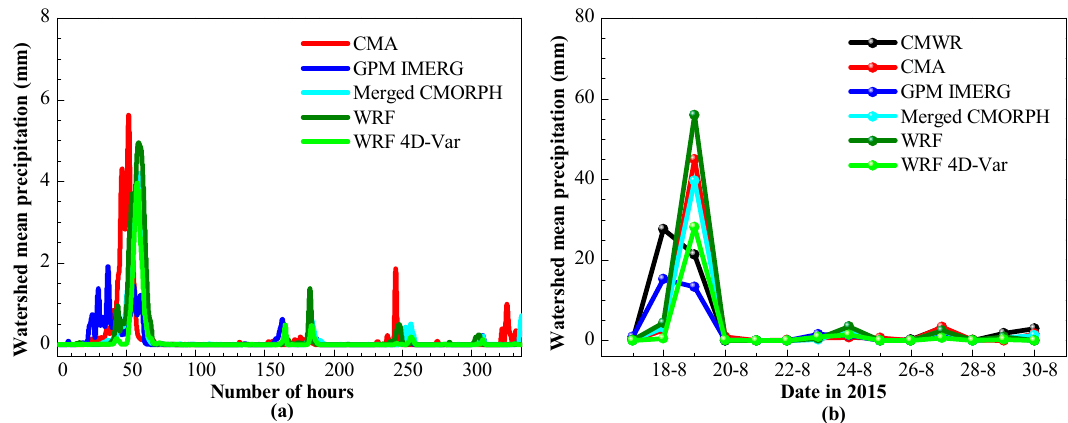
Figure 6. Averages of the hourly ( a ) and daily ( b ) precipitation (mm) in the WJB watershed obtained from different precipitation datasets during the study period.